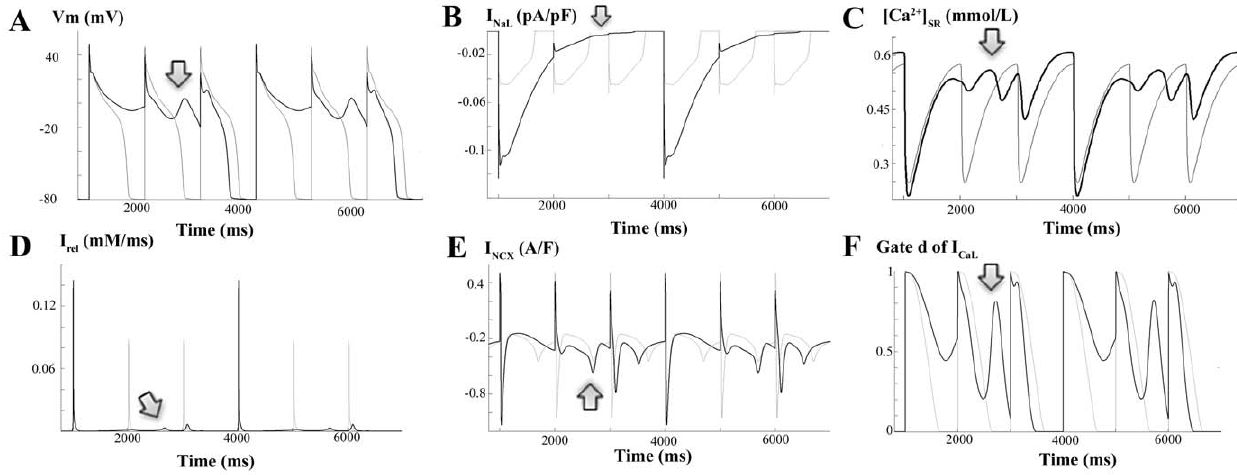
Figure 8. Mechanisms for early afterdepolarizations with enhanced I NaL . Simulated APs and ionic currents at a stimulating rate of 1 Hz for HF conditions, 50% inhibition of I Kr and 30% increase of I CaL . Panel A shows early afterdepolarizations (EADs; dark line) when I NaL was doubled and APs with no EADs when I NaL was normal (light line). The temporal evolutions of I NaL (panel B), I rel (panel D), I CaL (panel C), NCX activity (panel E), and activation gate of I CaL are also depicted when I NaL was doubled (dark line) and when I NaL was normal (light line).